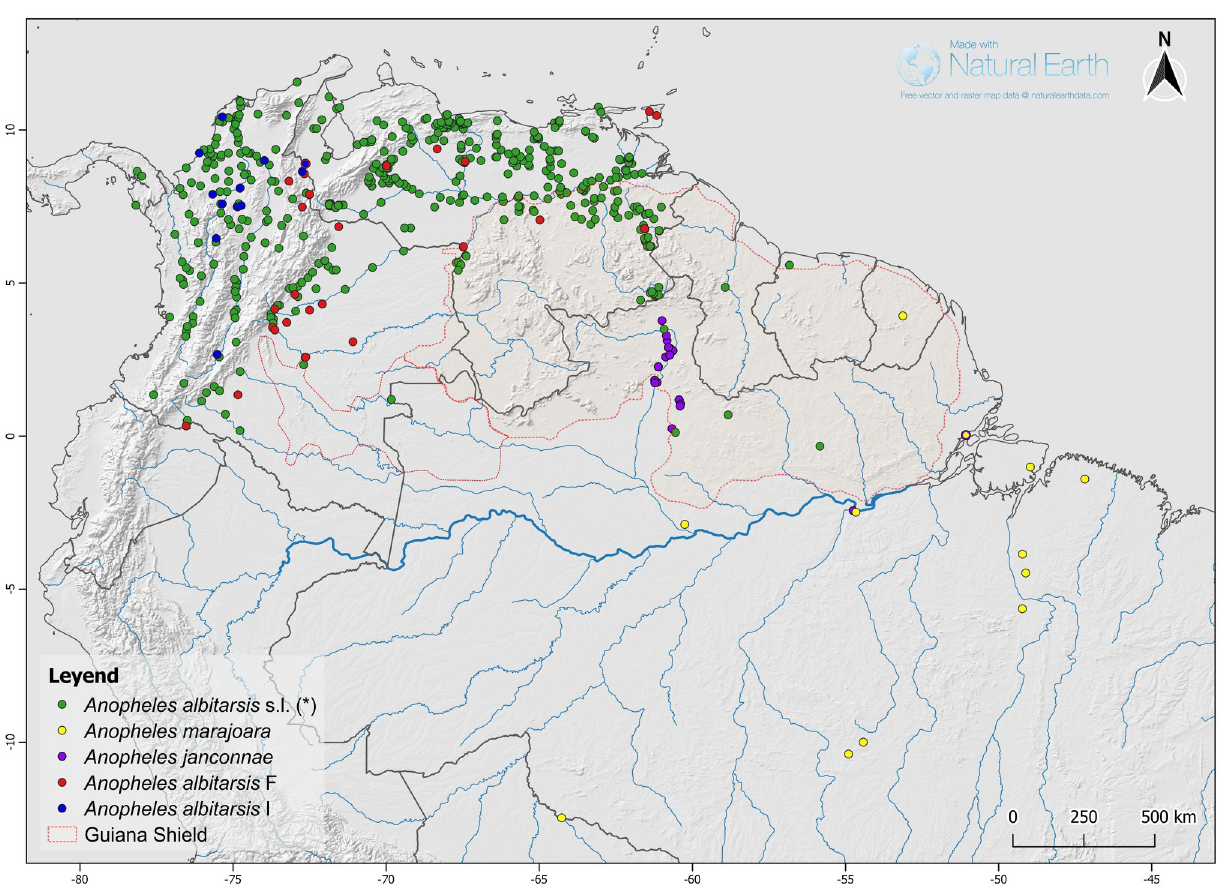
Fig 4. Geographic distribution of Anopheles albitarsis complex species in the north of South America. Note the distribution above the Amazon River of four species within the Anopheles albitarsis complex. ( � ) Species previously reported as An . albitarsis , An . marajoara or An . allopha were included as An . albitarsis s.l. The map was created in QGIS v 3.4 [59] using free vector and raster map data obtained from Natural Earth (public domain): naturalearthdata.com for illustrative purposes.